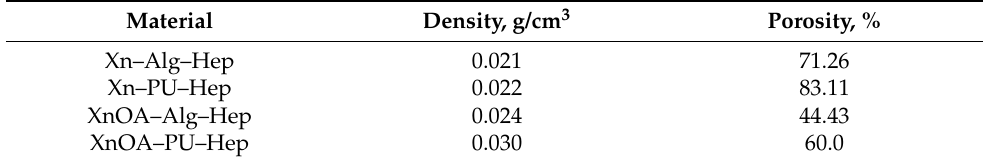
Table 3. Density and porosity of the tested